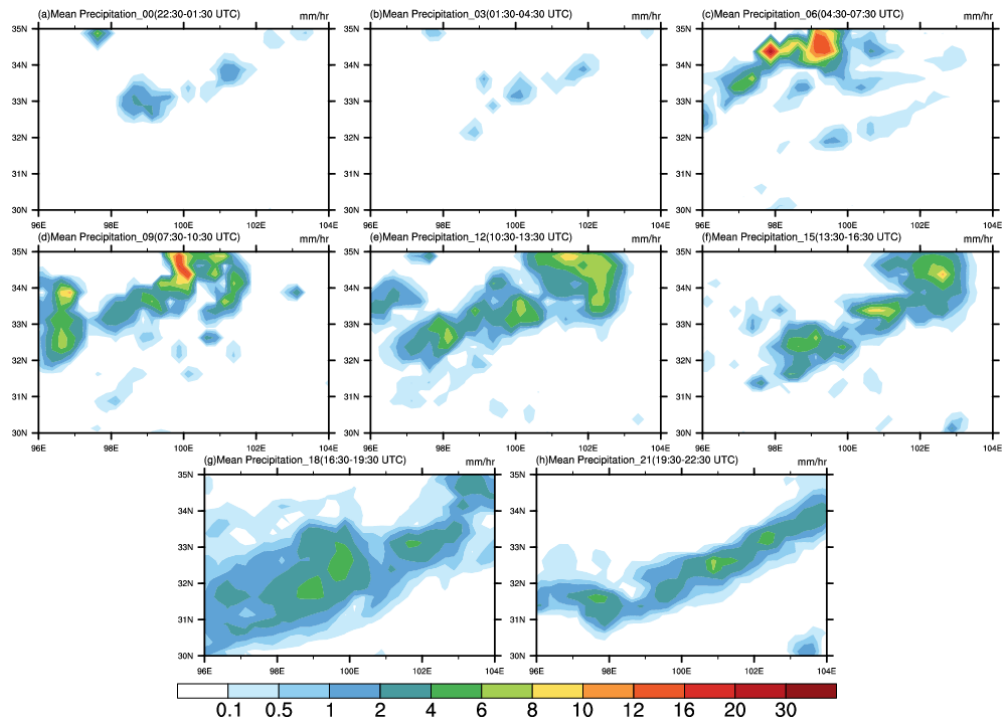
Figure 2. Spatial distribution of the mean 3-h precipitation rate (units: mm·h −1 ) over the southeastern Tibetan Plateau (30°N–35°N, 96°E–104°E) on 5 August 2014. ( a ) 22:30 (on 4 August 2014) –01:30 UTC; ( b ) 01:30–04:30 UTC; ( c ) 04:30–07:30 UTC; ( d ) 07:30–10:30 UTC; ( e ) 10:30–13:30 UTC; ( f ) 13:30–16:30 UTC; ( g ) 16:30–19:30 UTC; ( h ) 19:30–22:30 UTC.